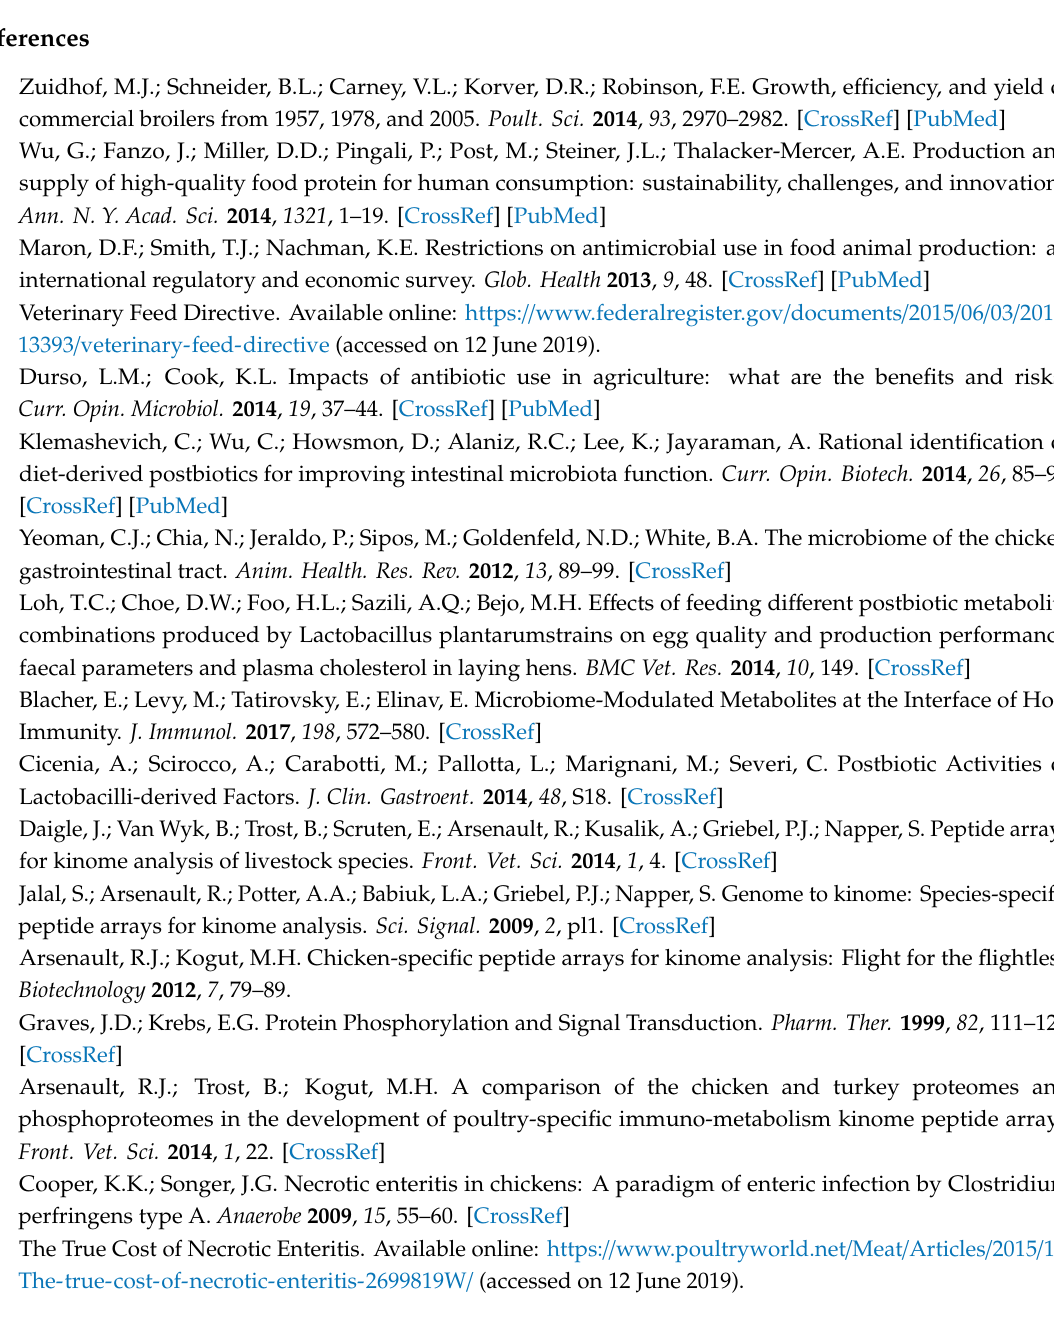
Table S1: Peptide Identifiers as Shown in Figure